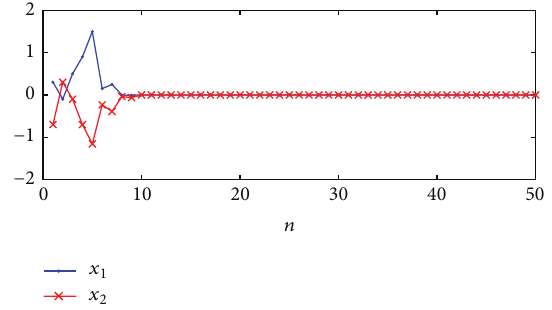
Figure 5: The response curves of system (39) with impulsive effects ( 𝛾 = 2.7556